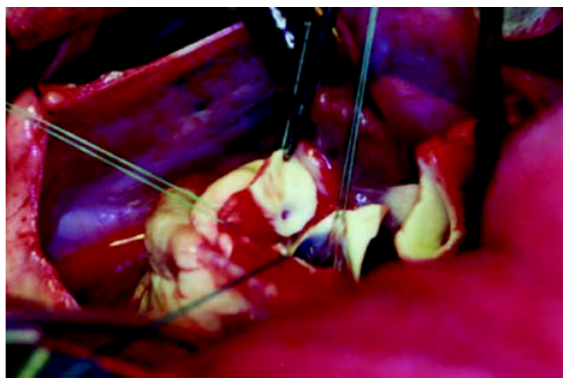
Fig.1 – Individualização dos óstios coronarianos.